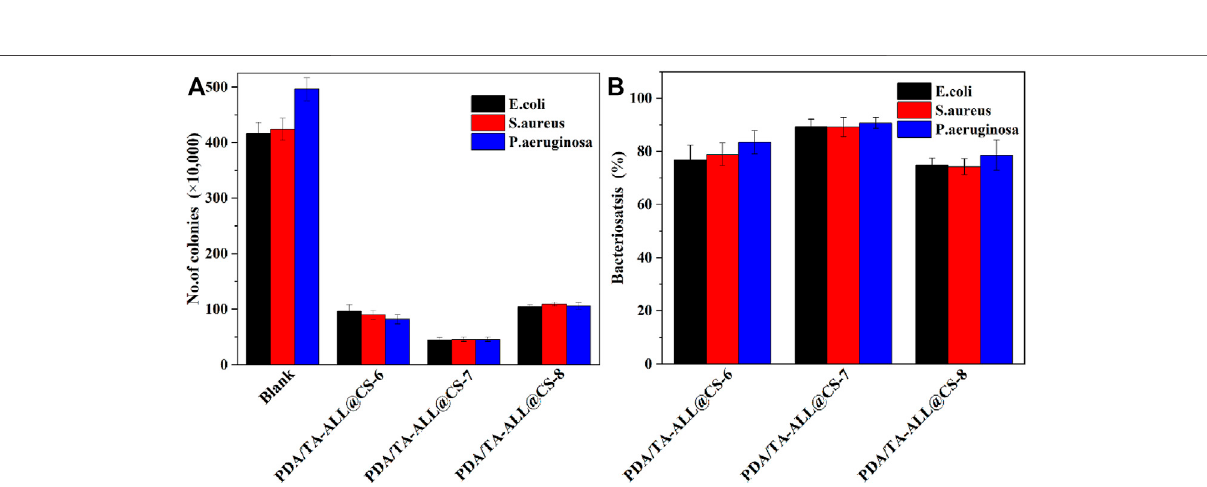
Frontiers in Materials |